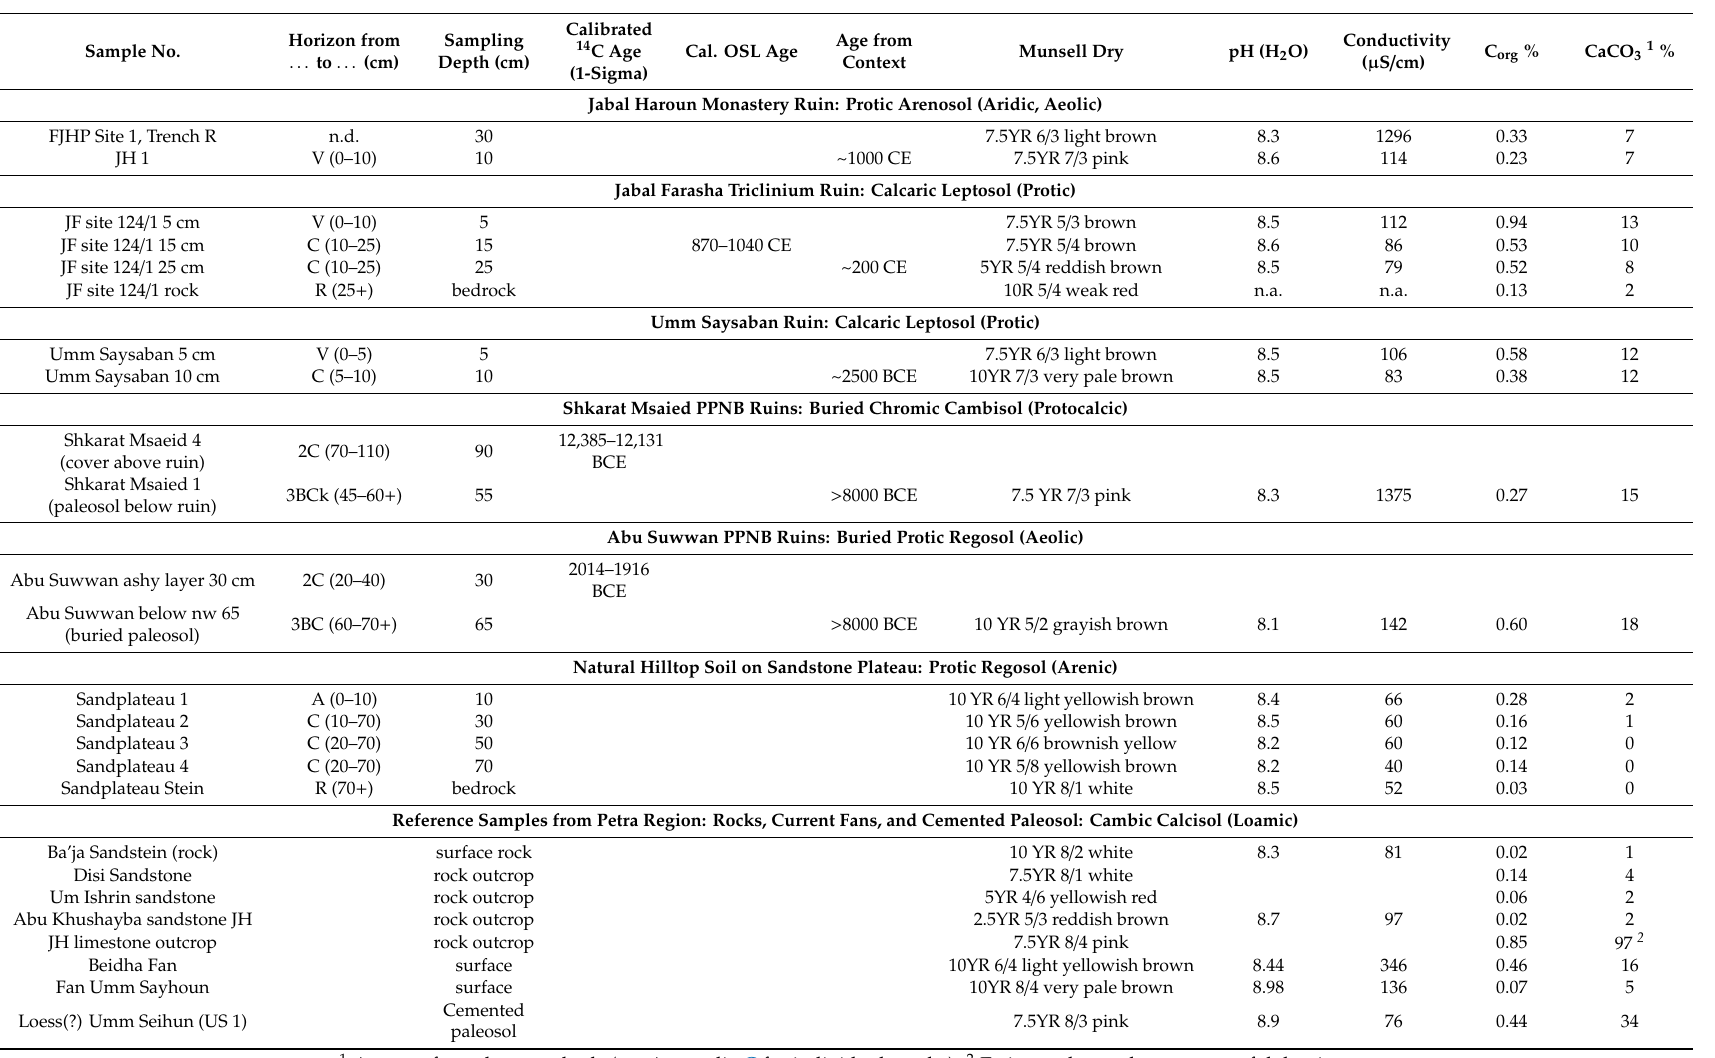
Table 3. General properties and calibrated ages of the ruin soils and samples from the vicinity of Petra. Sample